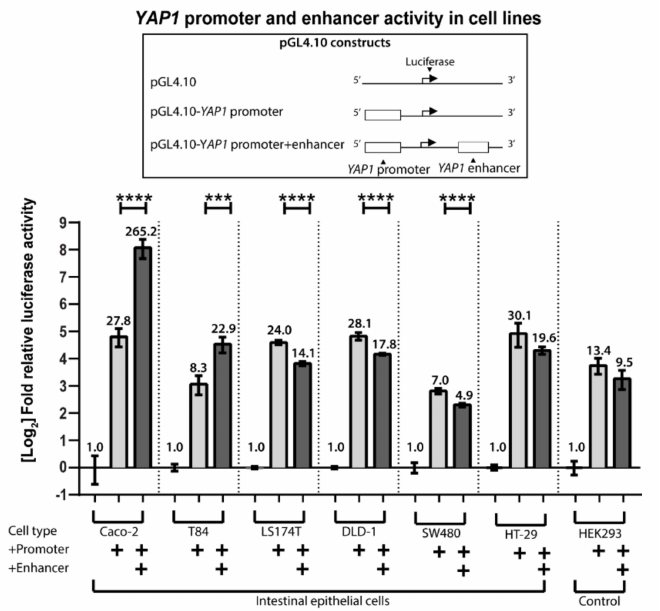
Figure 2. Relative luciferase / β -galactosidase activity from cell lysates of the intestinal cell lines Caco-2, T84, LS174T, DLD-1, SW480, and HT-29 transfected with pGL4.10 luciferase reporter constructs containing the YAP1 promoter and + 82 kb enhancer. HEK293 cells are used as a non-intestinal control. Vertical lines separate data from independent assays. Bars are mean values on a log2 scaled y -axis, with error bars showing SD, n = 4). + indicates that either the YAP1 promotor or enhancer sequence was inserted in to the luciferase construct sequence. Statistical significance was obtained using one-way ANOVA with p -values under 0.001 (***) and 0.0001